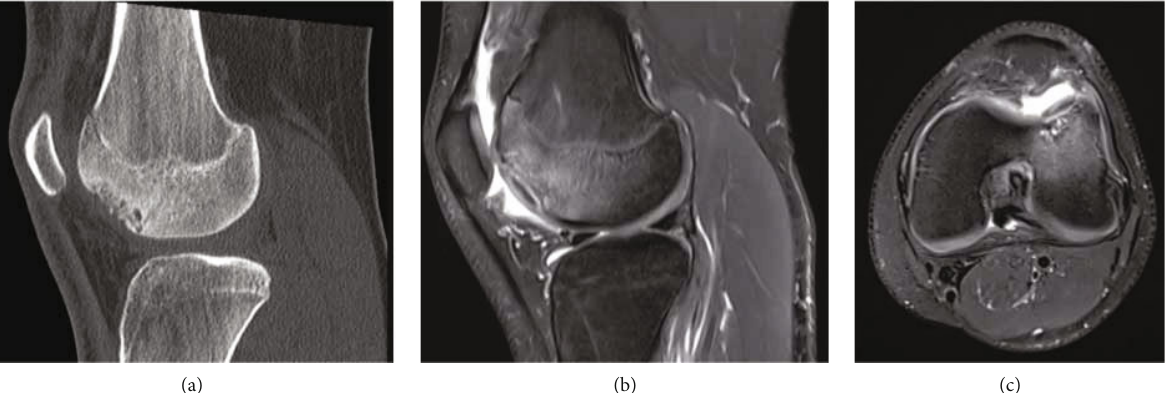
Figure 1: Tomographies of the left knee in a 17-year-old male. (a) CT through the lateral femoral condyle in a sagittal plane showing subchondral cysts. (b, c) MRI in T2-weighted sagittal and axial planes showing subchondral fl uid as a sign of dissecate instability.